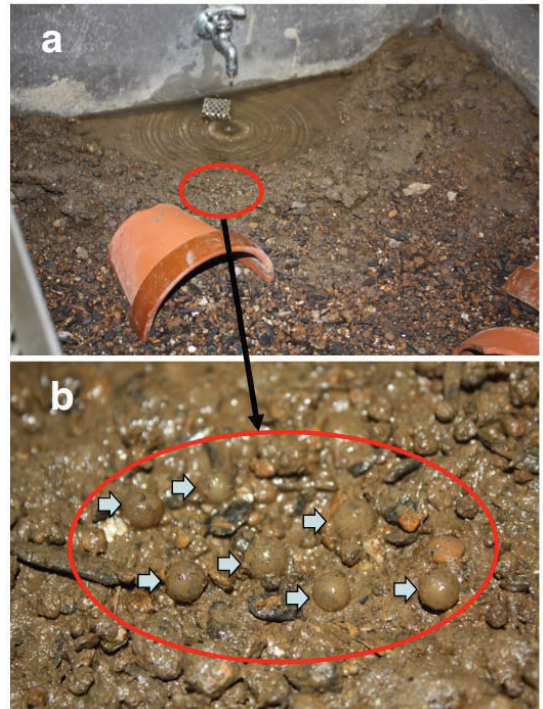
Figure 4. Eggs deposited on the slope in the vicinity of the waterfront in the cage. ( a ) The slope in the vicinity of the waterfront in the breeding cage, not directly submerged. ( b ) Eggs deposited on the slope are indicated by